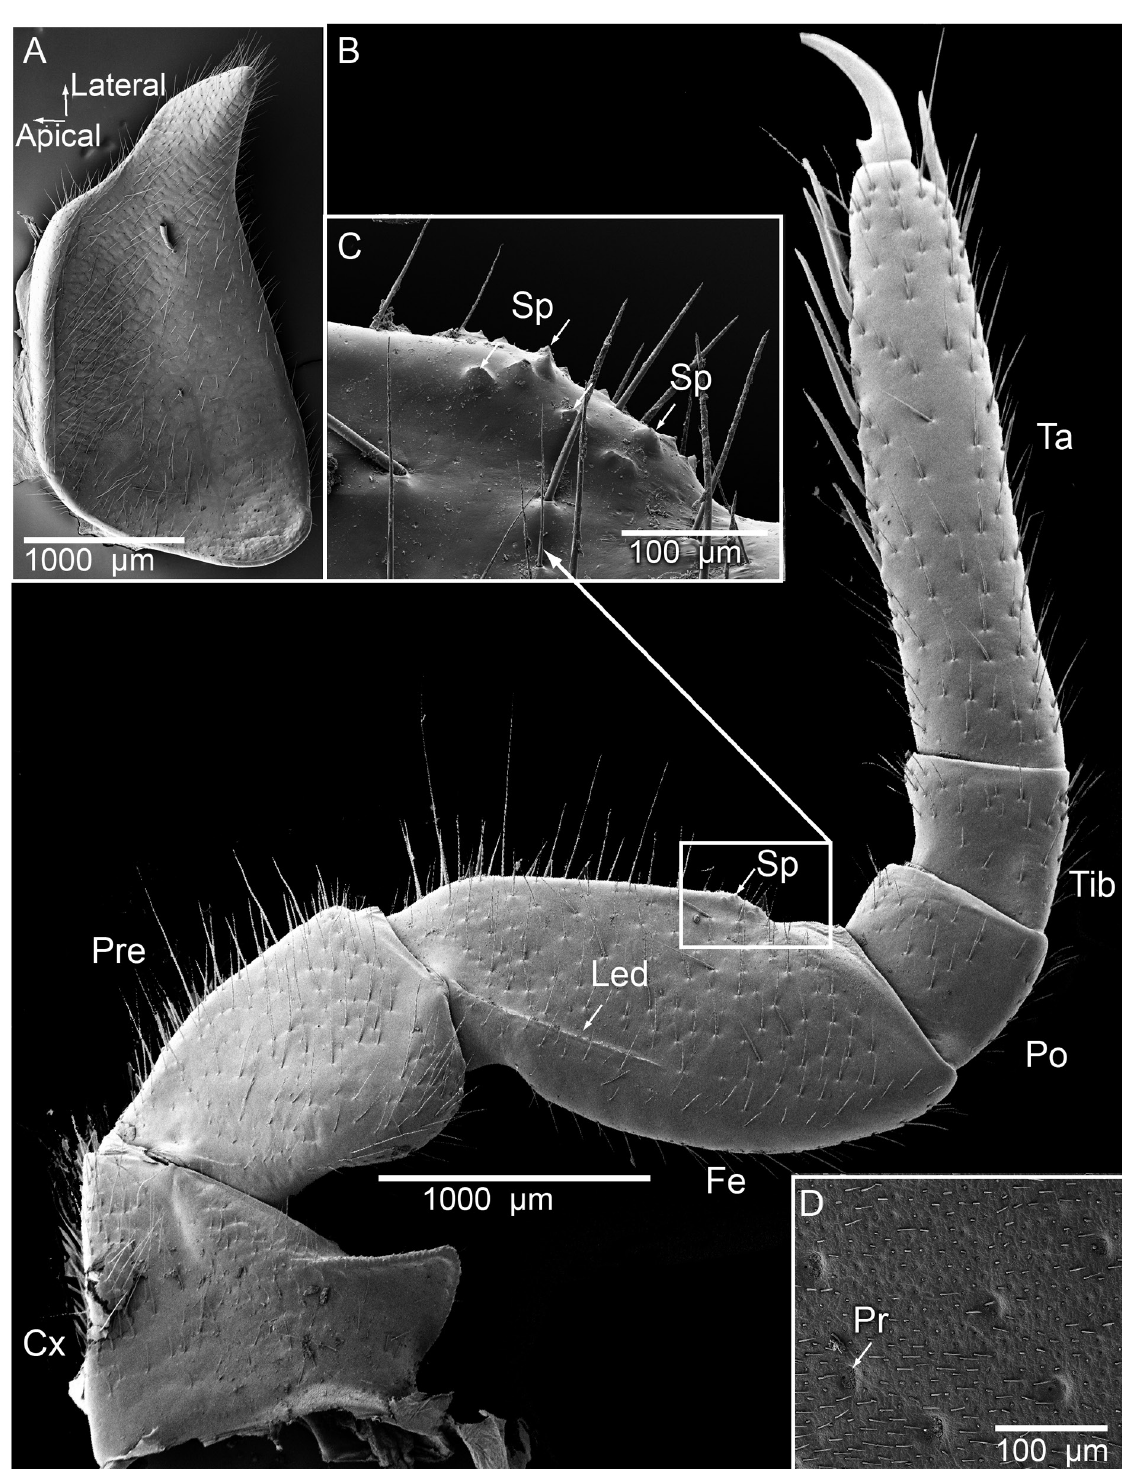
Fig. 9. Zephronia viridisoma Rosenmejer & Wesener sp. nov., paratype, ♂ (ZFMK MYR8786), legs and pleurite (laterotergite), scanning electron micrographs. A . First pleurite. B . Left midbody leg, posterior view. C . Leg, femur, detail of sclerotized teeth. D . Surface of midbody tergite. Abbreviations: Cx = coxa; Fe = femur; Led = ledge; Po = postfemur; Pr = protuberance; Pre = prefemur; Sp = small triangular spines; Ta = tarsus; Tib =